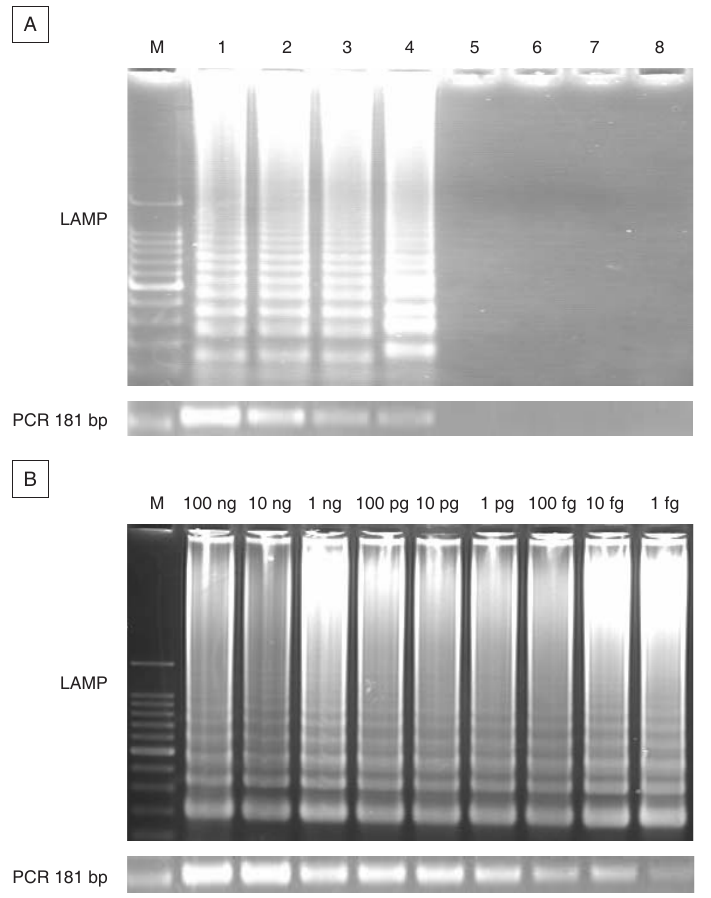
(A) Specificity tests of LAMP and PCR (F3, B3) primers for detection of bovine Theileria spp. DNA. Lanes M: 100 bp maker; 1: T. parva ; 2: T. annulata ; 3: T. taurotragi ; 4: T. mutans ; 5: T. orientalis ; 6: B. bovis ; 7: T. brucei ; 8: Bovine blood. (B) Sensitivity of LAMP and PCR (F3 and B3) primers for detection of Theileria parva DNA quantified with a spectropho- tometer (Smart Spec 3000, USA) and serially diluted from 100 ng to 1